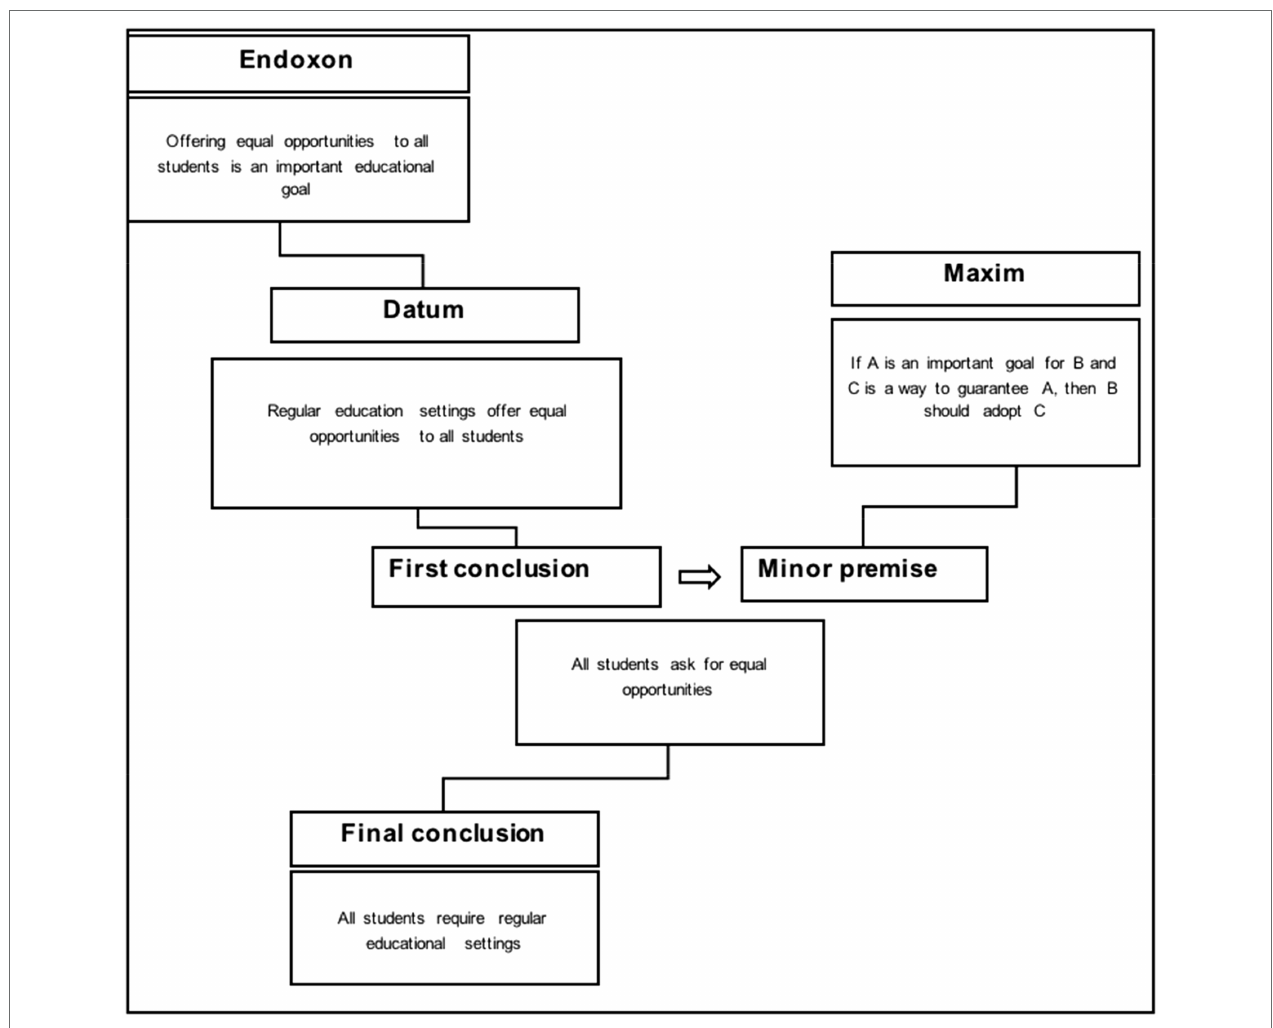
FIGURE 2 | AMT-based reconstruction of the second